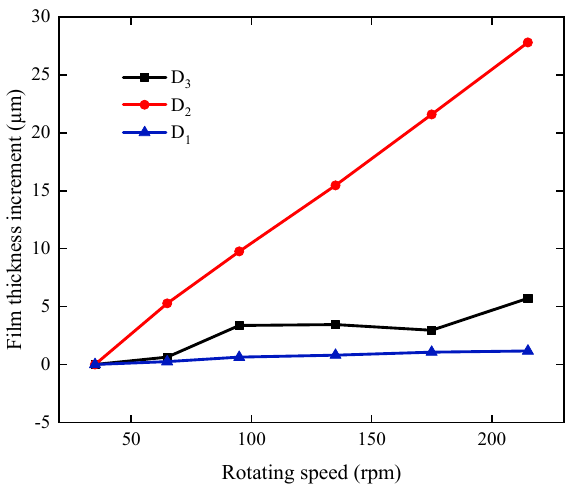
Figure 10. Minimum film ‐ thickness increases for each section based on 35 rpm.